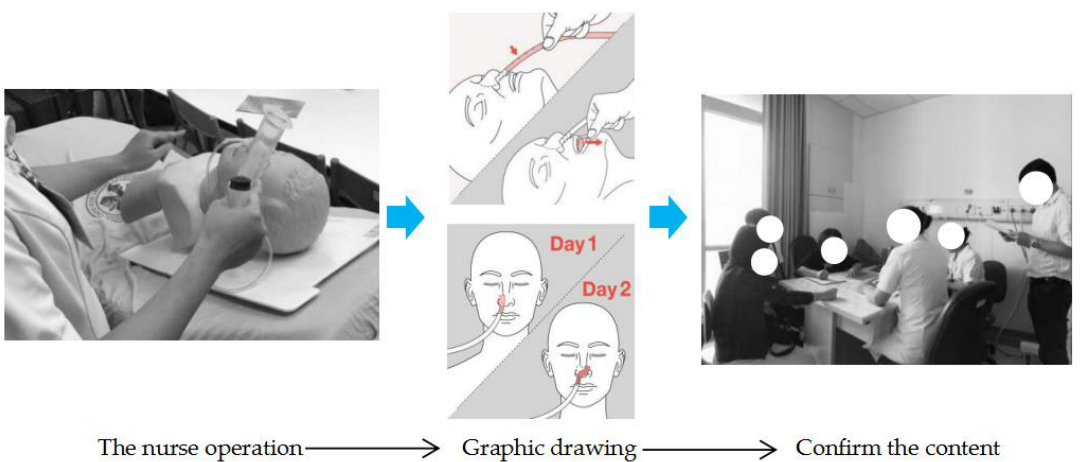
Figure 4. Transformation and content confirmation of nasogastric tube home caring graphics.